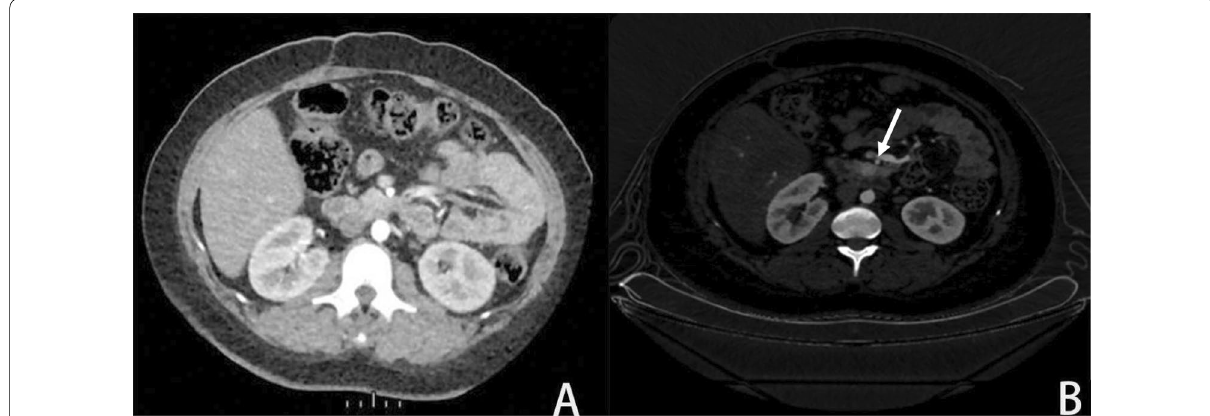
Fig. 1 Representative pNETs image under conventional pancreas perfusion scan ( a ), in which the lesions in the uncinate process are poorly developed; the lesions are clearly displayed on the energy spectrum CT image of the arterial phase ( b